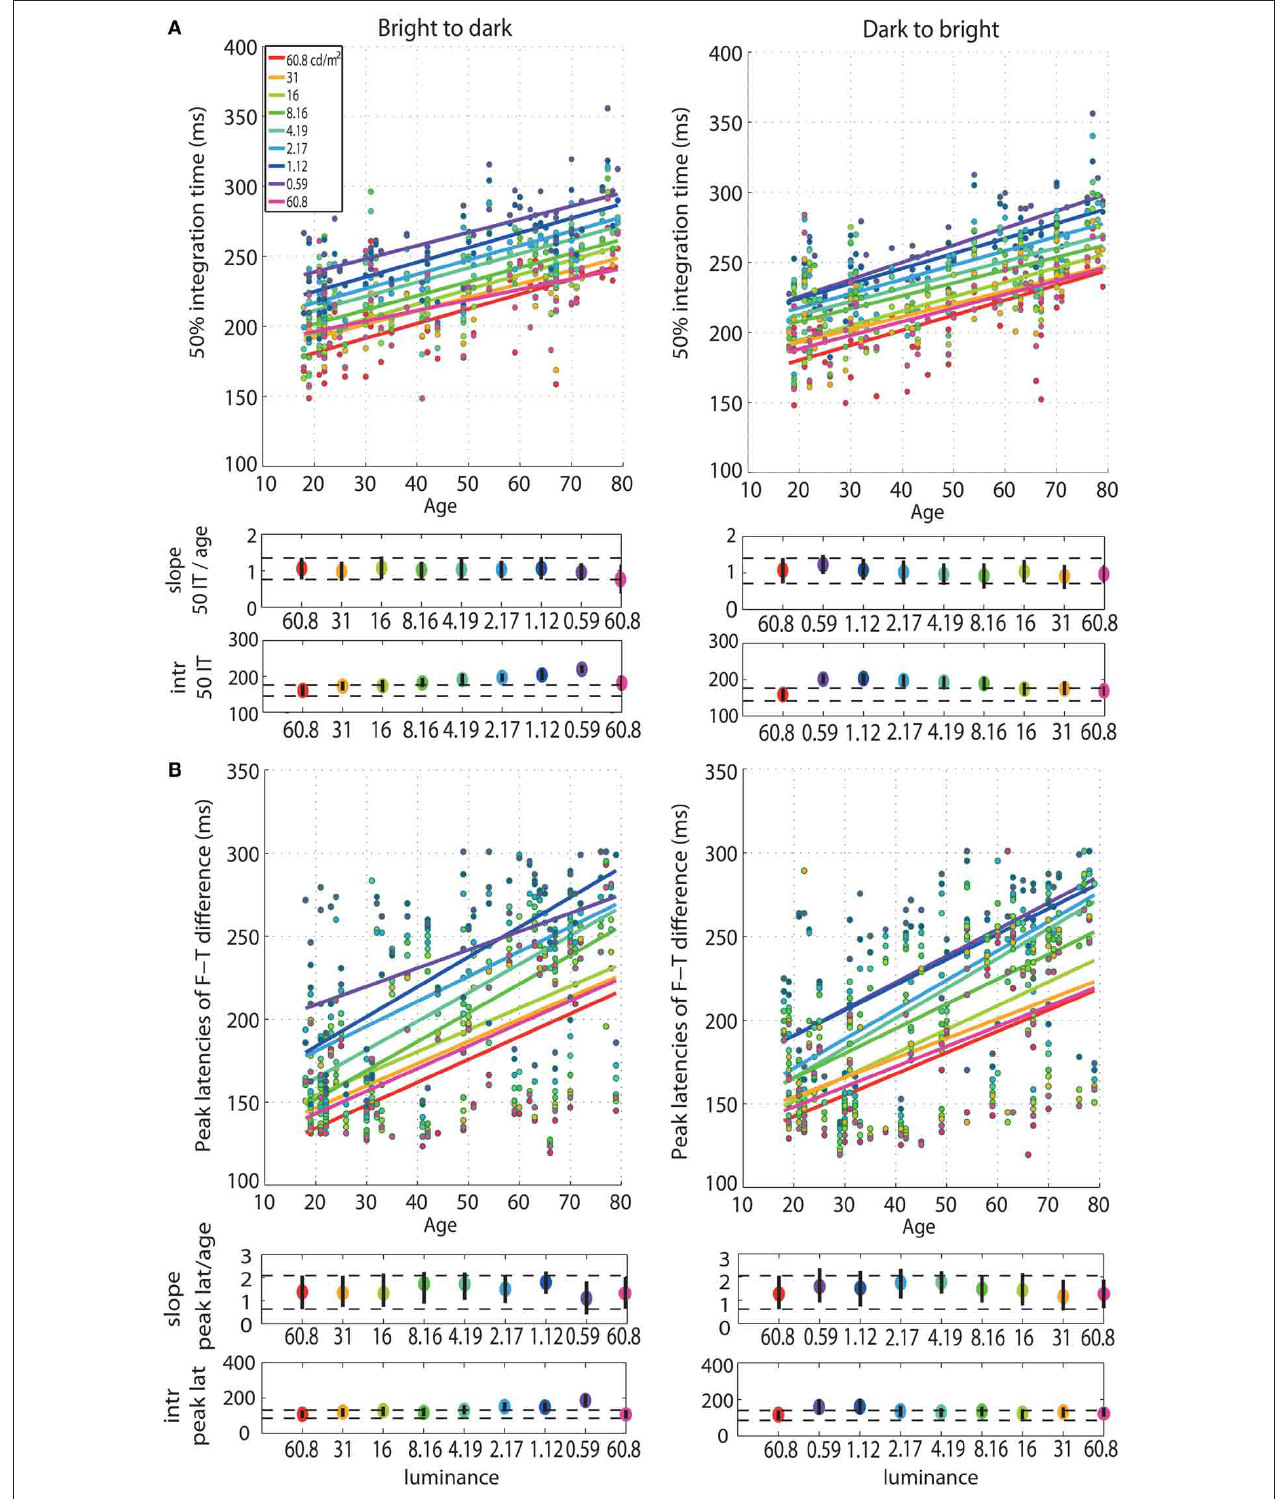
FIGURE 3 | Regressions of 50IT and peak latencies of face-texture ERP differences against age. (A) Regression fits between 50IT and age and (B) latencies of maximum face-texture ERP differences, for all luminance levels. B2d sessions are shown in column 1, d2b sessions in column 2.